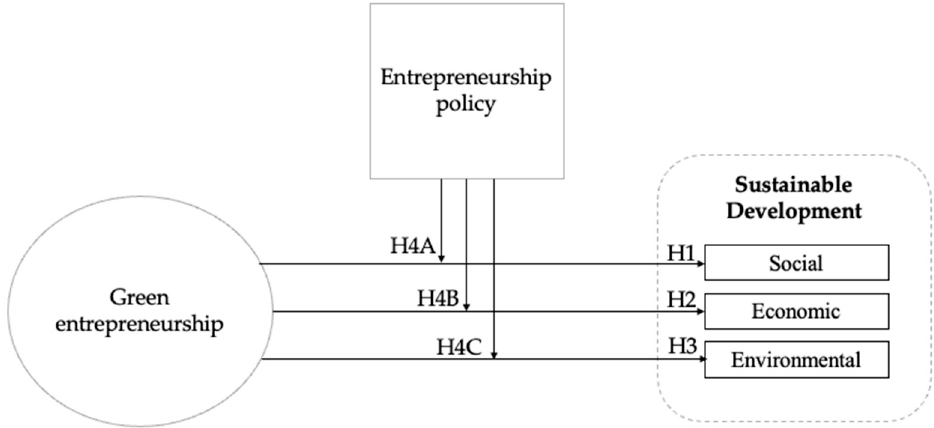
Figure 1. Conceptual model.